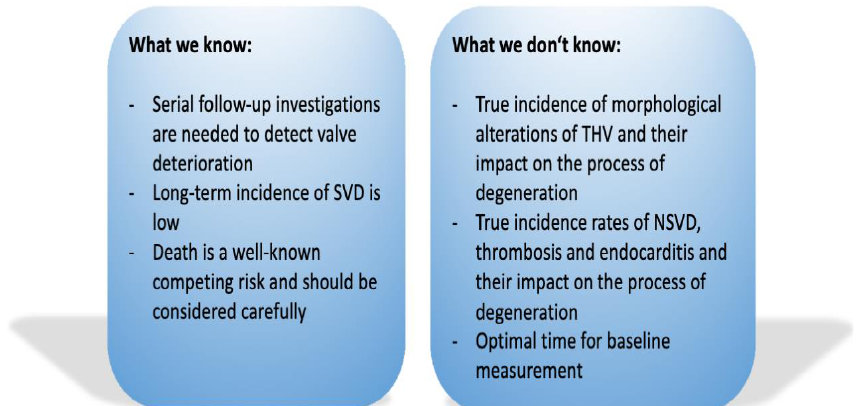
Figure 2. Simplified illustration of current knowledge and future aspects in durability of transcatheter heart valves. SVD, structural valve deterioration; THV, transcatheter heart valve; NSVD, non-structural valve deterioration.